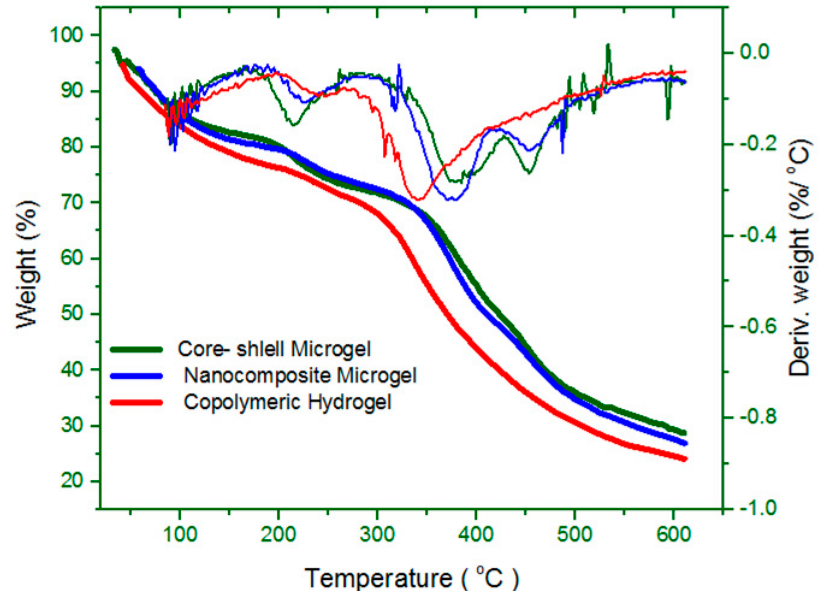
Figure 7. TGA curves of synthesized samples.